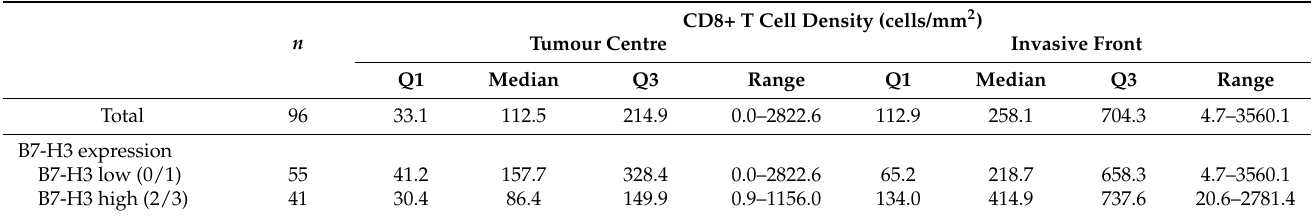
Table 2. The median density of CD8+ T cells between tumour compartments in relation to B7-H3 expression.